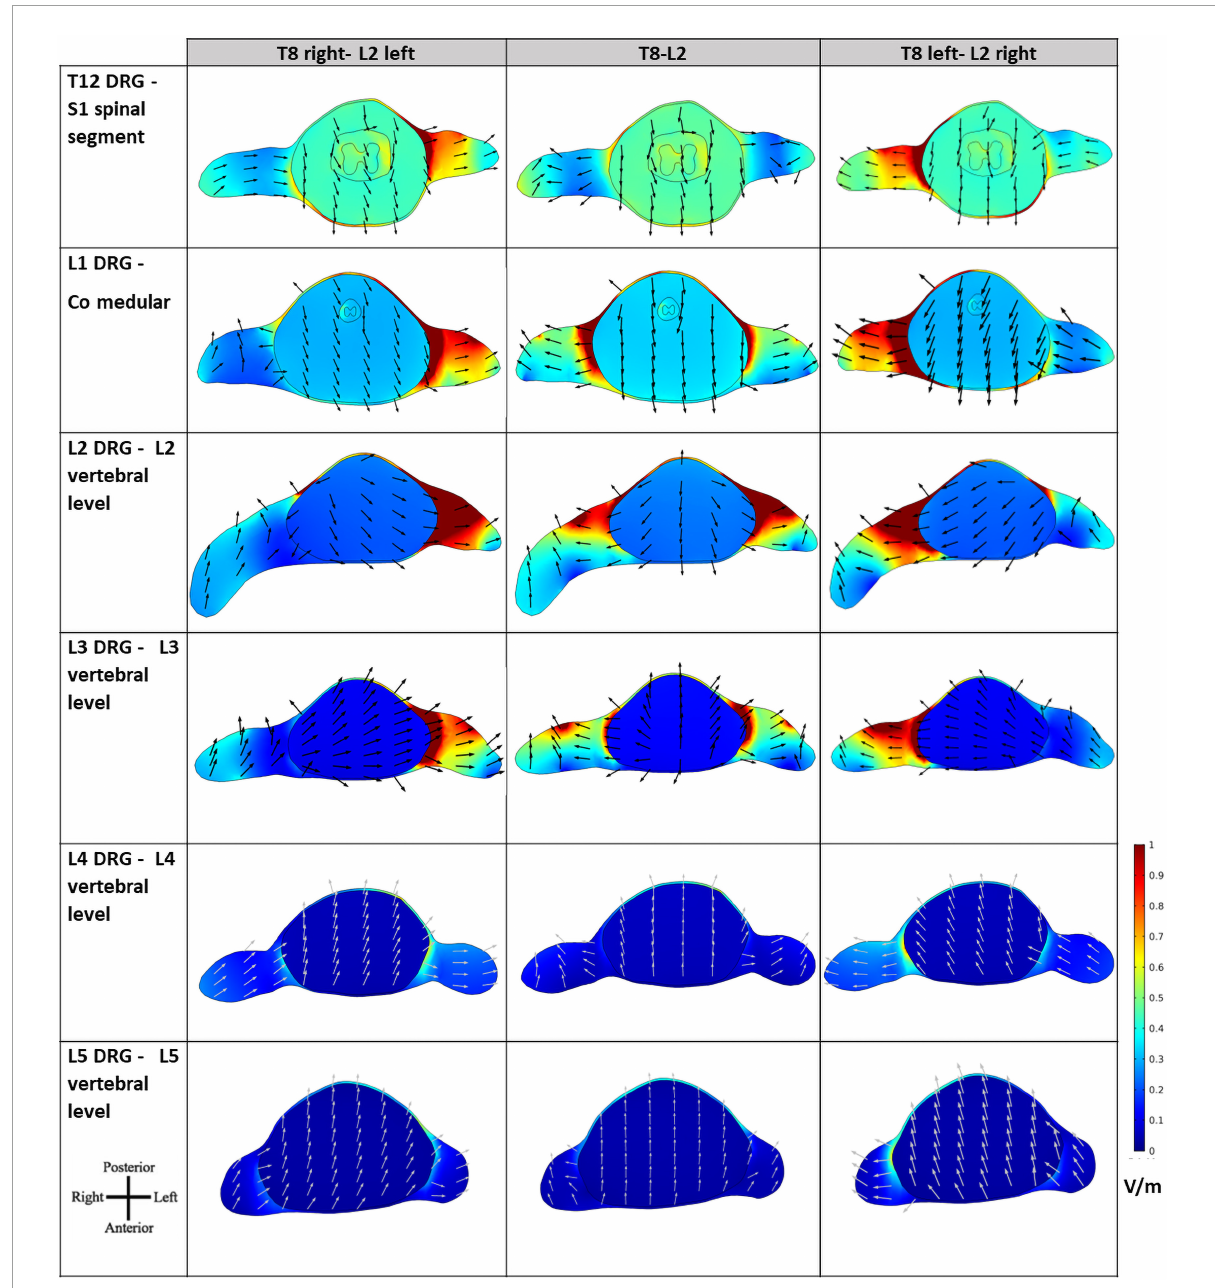
FIGURE7 Electric field (E-field) magnitude distribution and direction in transverse slices of the spinal cord (SC) at the levels of the lumbar dorsal ganglia. The orientation of the slices is shown in the bottom left corner and color scale in V/m is represented on the right. E-field direction is indicated by black arrows of the same